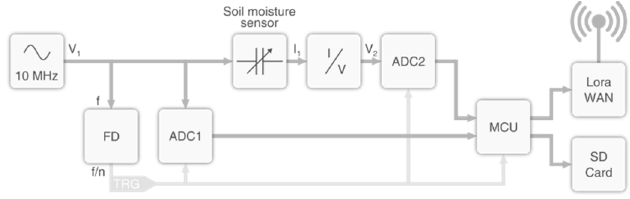
Figure 1. IoT electronic measuring unit.